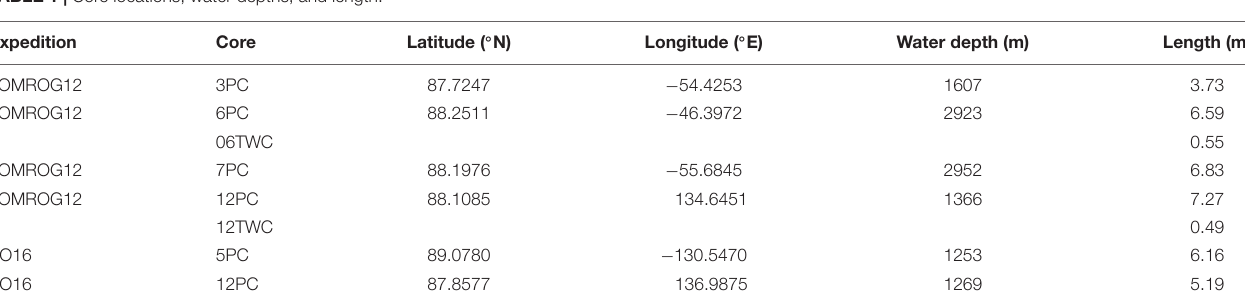
FIGURE 3 | Bathymetric map of the central and western Lomonosov Ridge showing locations of sediment cores discussed in the text. Black circles are cores for which a coherent downhole lithostratigraphy is shown in Figure 5 , or in the case of AO96-12PC has been illustrated in previous work (O’Regan et al., 2008a,b) and is shown in Figure 10 . White circles are locations of other cores discussed in the text. Core AO16-12PC was collected at the location on the Lomonosov Ridge drilled in 2004 during ACEX. At the resolution of this map they are both represented by the same black circle. TABLE 1 | Core locations, water depths, and